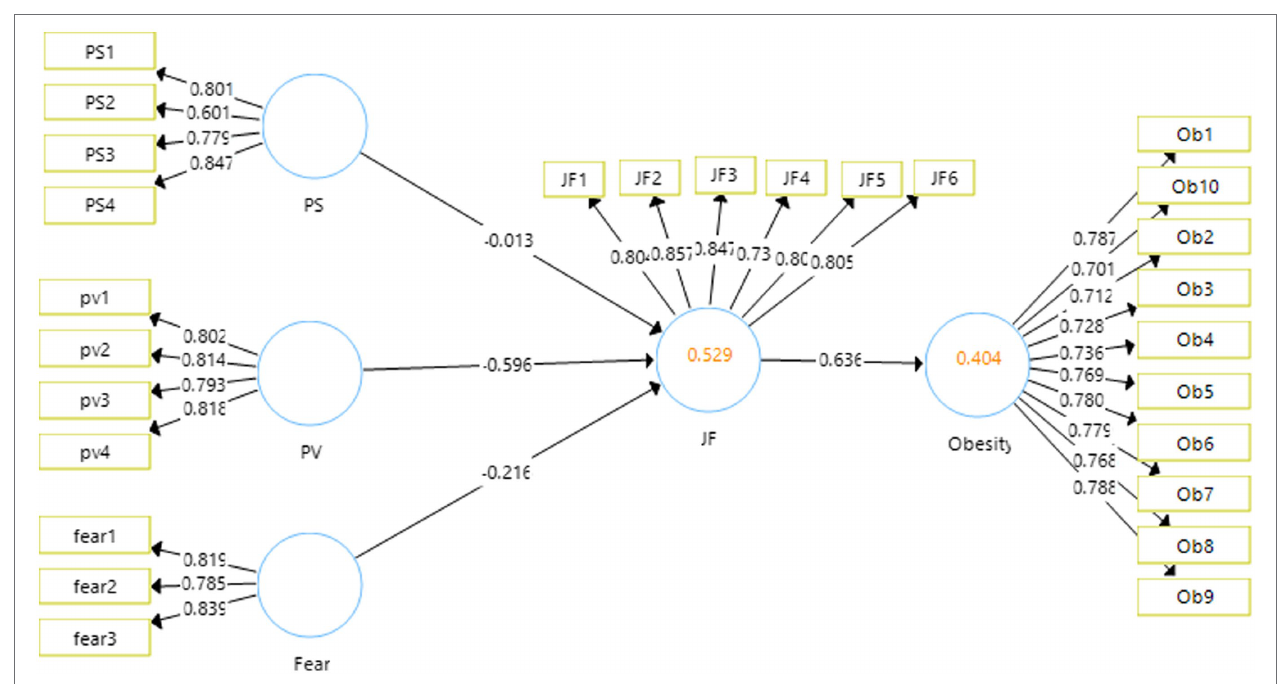
FIGURE 2 | Output of measurement model. PS, perceived severity; PV, perceived vulnerability; JF, junk food eating